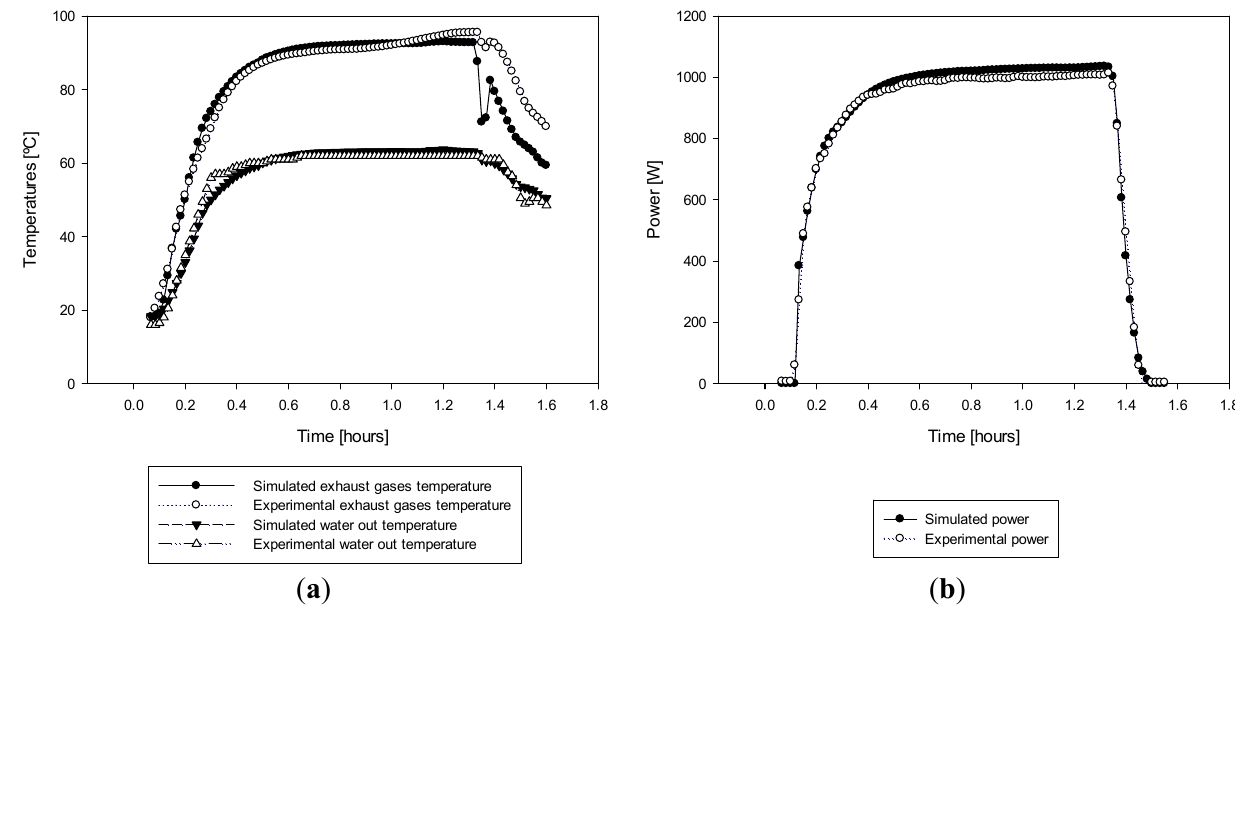
Figure 12. ( a ) Simulated and experimental outlet water temperature and exhaust gases temperature for T = 45 °C; ( b ) Simulated and experimental power for T set capacitance and heat transfer coefficient values are given in Table 1 (last